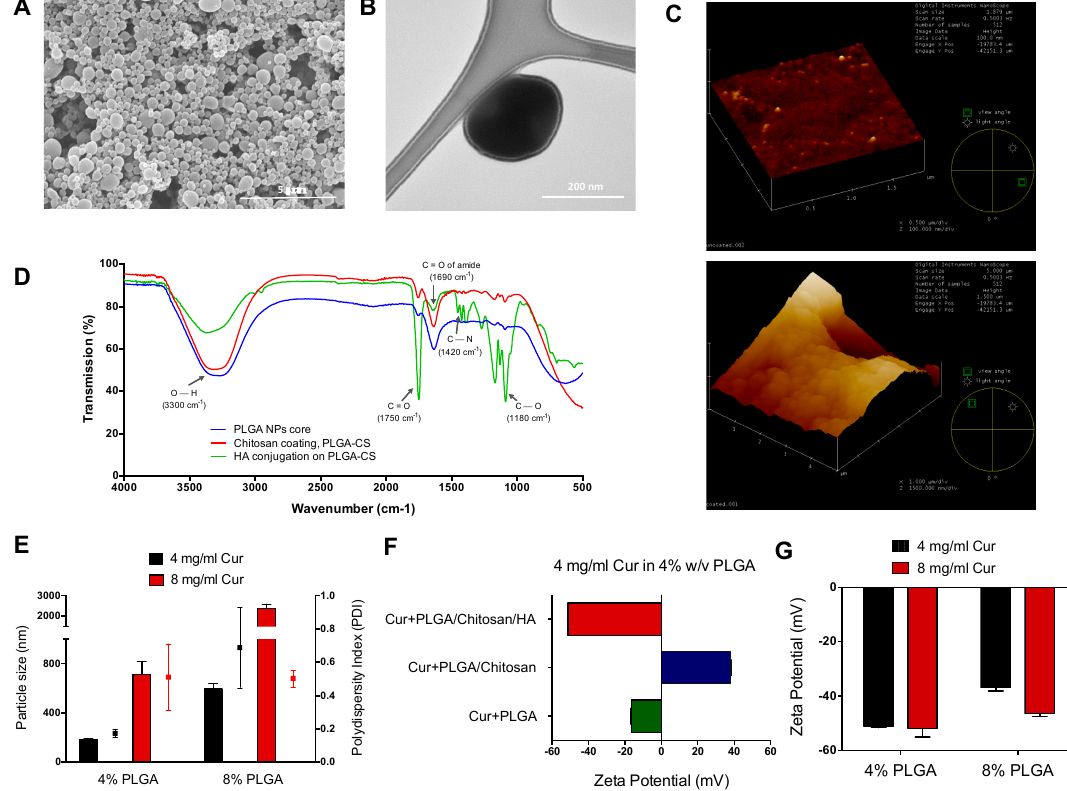
Figure 2. Morphological, physicochemical properties of curcumin loaded polymeric hybrid nanoparticles. Scanning electron microscopy image of HA conjugated NPs (scale bar = 5 µm) ( A ). Transmission electron microscopy image showing the coated layer of the individual nanoparticle (scale bar = 200 nm) ( B ). AFM images of uncoated, HA conjugated NPs ( C ). FT-IR graph showing the hyaluronan (-COOH) conjugation on PLGA-Chitosan (+NH2) core ( D ). Size and PDI of 4, 8 mg/mL drug to 4%, 8% polymer ratio ( E ). Change in surface zeta potential after each layer of coating with chitosan and hyaluronan conjugation respectively ( F ). Zeta potential of di ff erent groups of drug to polymer ratios ( G